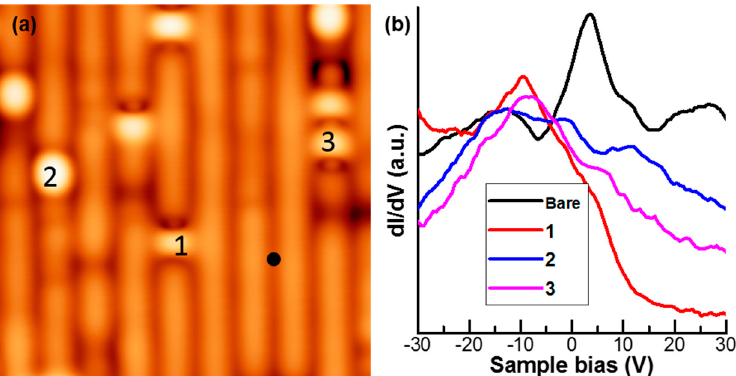
Figure 5. ( a ) STM atomic resolution image in a pristine area of Pr-Ca122 surface with ( V S = − 2 mV, It = 200 pA, T = 4.2 K). ( b ) The dI/dV spectra taken at three different pristine defects are very different from one taken at the bare area, and they all show no superconducting gap.